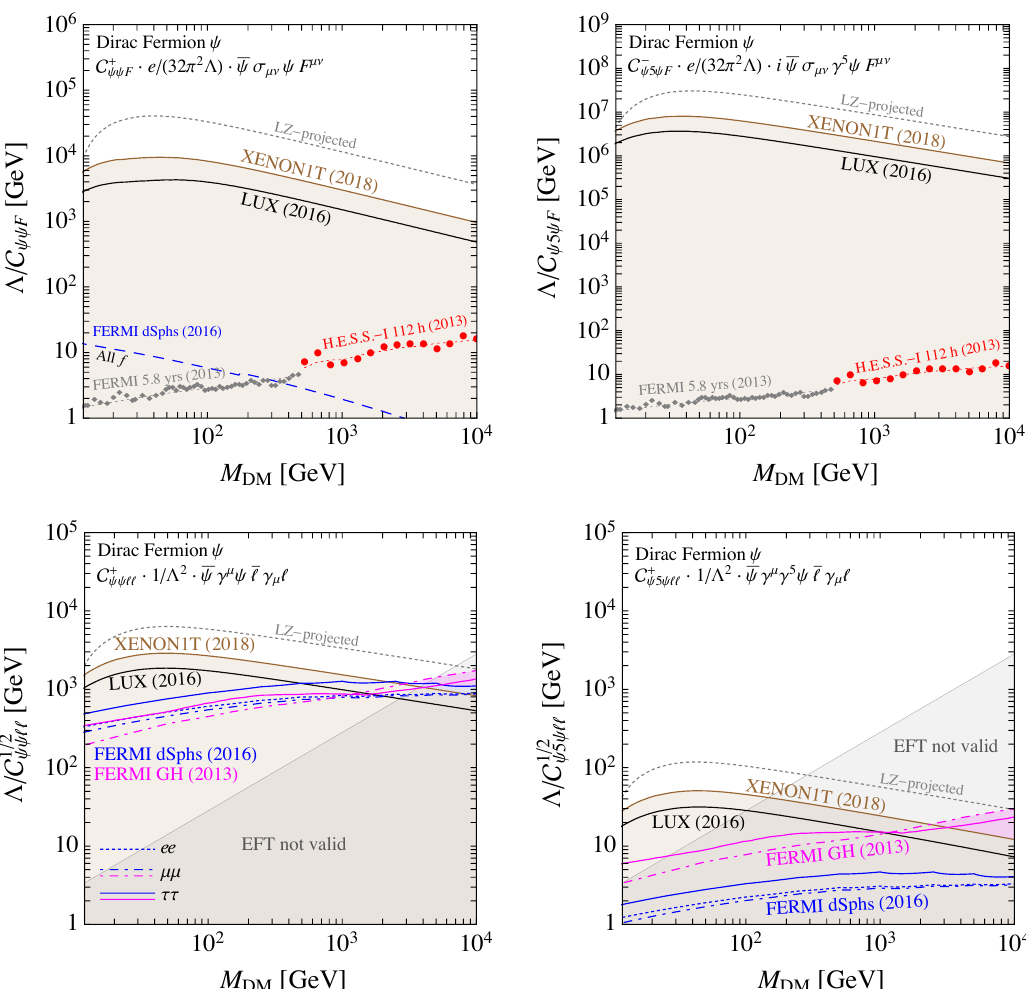
Figure 1 . Constraints from direct and indirect detection on high-scale operators which give rise to DM-photon couplings at low energy, in the case of Dirac fermion DM . The relevant operators are discussed in detail in section 2.1 and section 2.2, and we have indicated the CP parity the operator coe(cid:14)cient. In each panel we show constraints on a di(cid:11)erent operator, speci(cid:12)ed in the upper left. More details of the bounds are given at the start of section 3. Note the di(cid:11)erent vertical scales in the top two